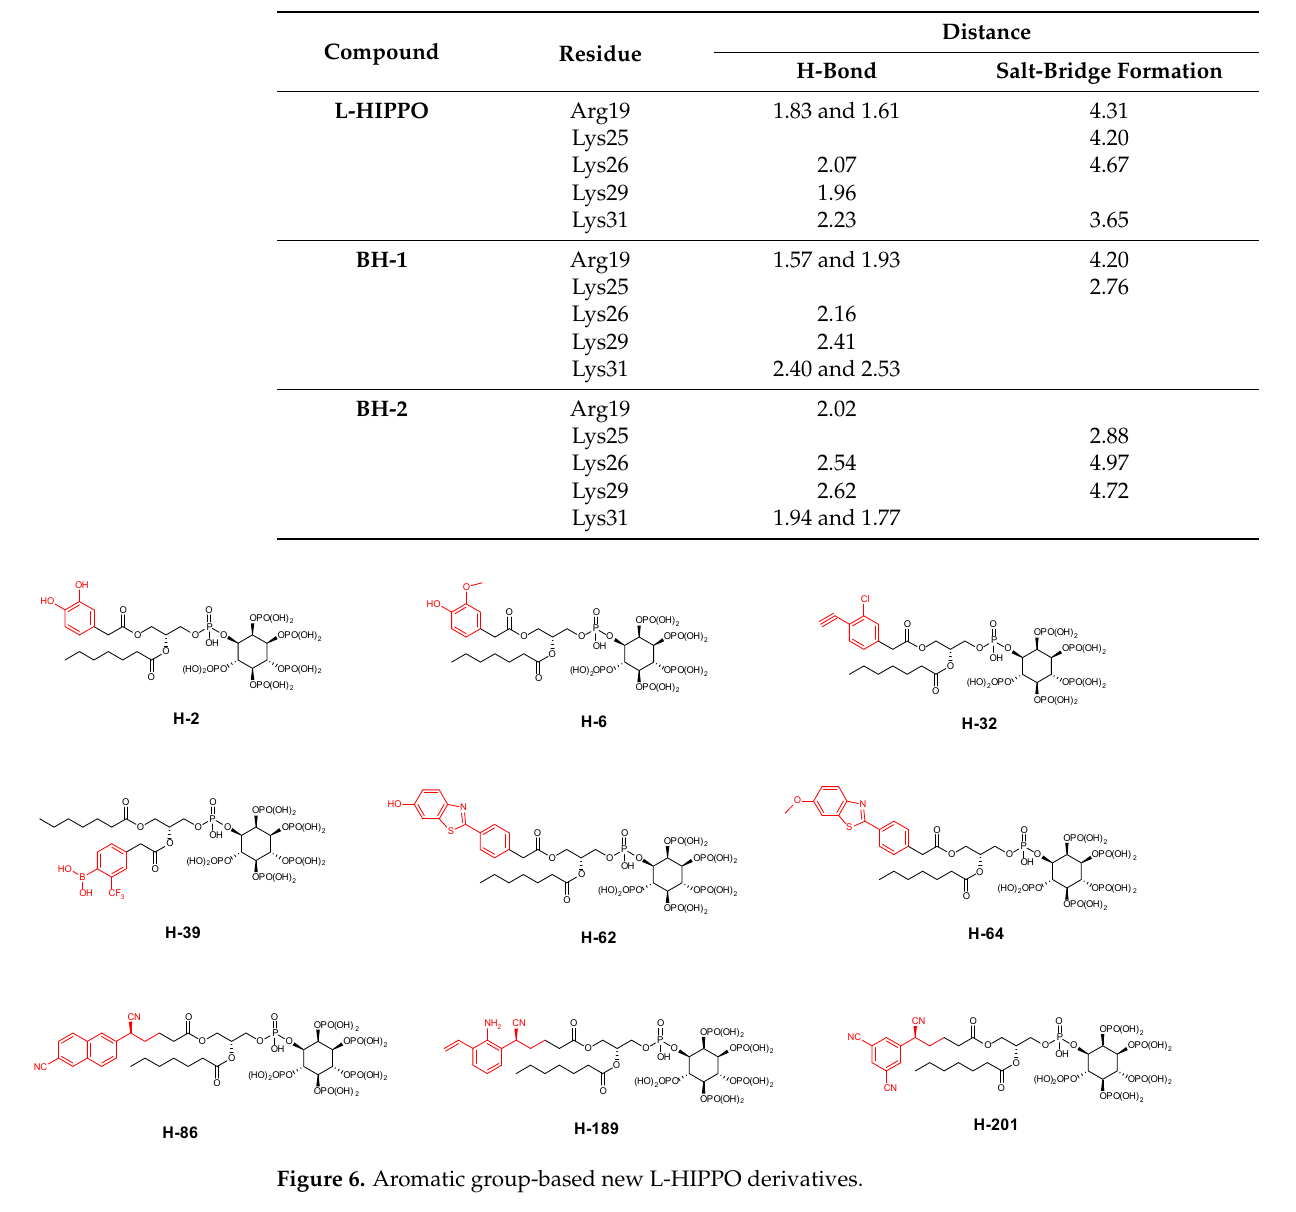
Table 2. The H-bond and salt bridge formation distances of BH-1, BH-2, and L-HIPPO (angstrom) in the MA domain (PDB ID: 7E1I).